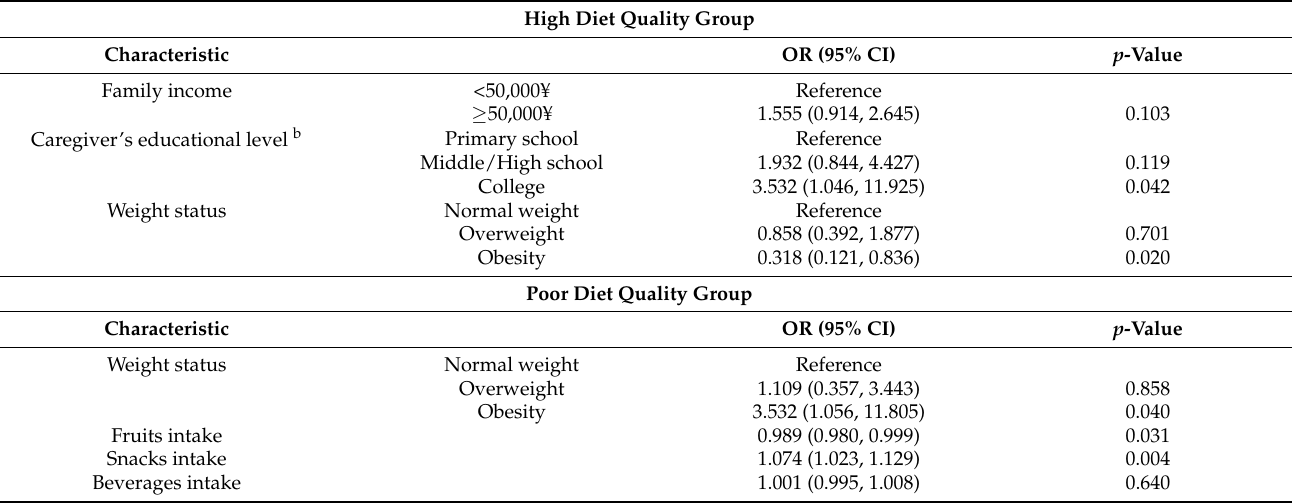
Table 5. Regression model of the relationship between caregiver’s perception and other socio- demographic predictors, and intake of some kinds of food a